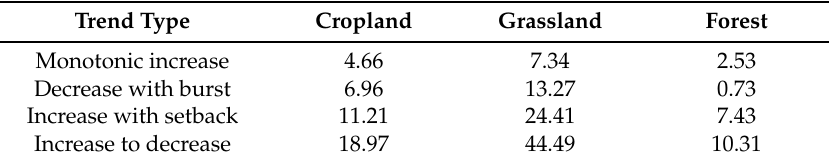
Table 1. Percentage of change types in each land cover class.